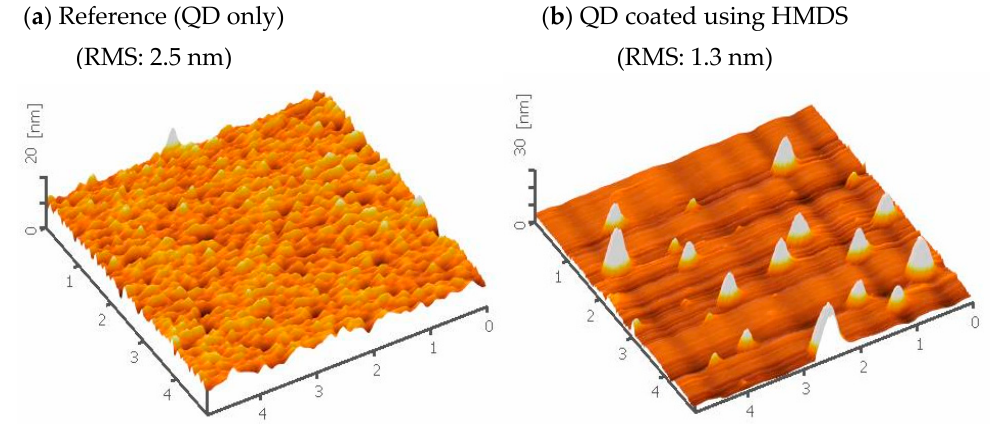
Figure A1. Atomic force microscope (AFM) images show the roughness of the electron transport layer (EML) layer without ( a ) and with ( b ) the HMDS treatment. A comparison of the root mean square (RMS) values indicates the HMDS treatment of QDs results in the smooth surface morphology in addition to the uniform distribution of QDs.